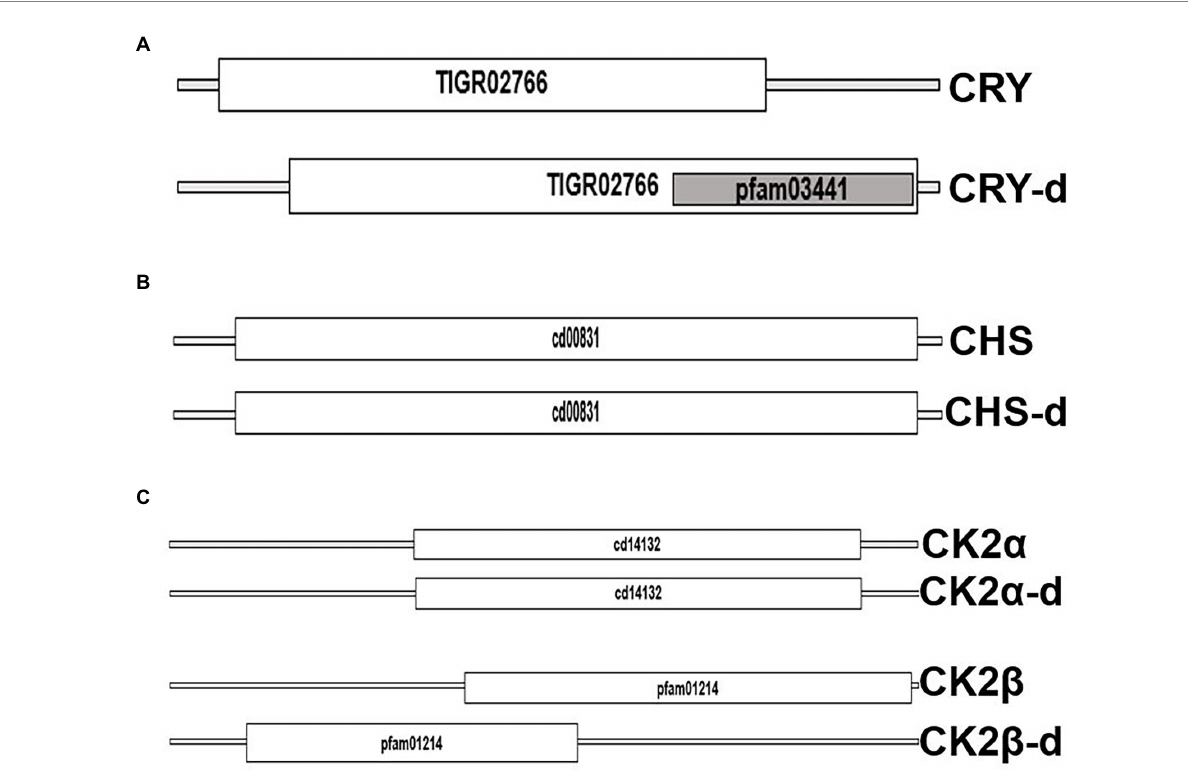
FIGURE 2 Domain level comparison of known plant clock proteins in dinoflagellates. The reference proteins were obtained from the Plant circadian rhythm sub-section of the KEGG pathway database. “-d” denotes respective proteins from dinoflagellates (A) Cryptochrome 2, the clock input protein, which is the blue light receptor and denoted as CRY, (B) Chalcone synthase, CHS, the first enzyme in flavonoid biosynthesis, and (C) the CK2 alpha and beta subunits known to phosphorylate the core clock proteins that fine tunes the 24-h timing of the